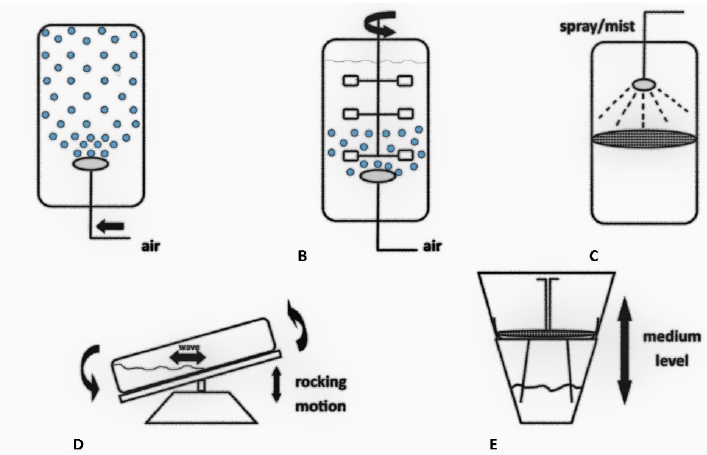
Figure 2. The types of bioreactors most often used for the cultivation of plant cultures in vitro. ( A ) Bubble column bioreactor, ( B ) Stirred tank bioreactor, ( C ) Nutrient mist or sprinkle